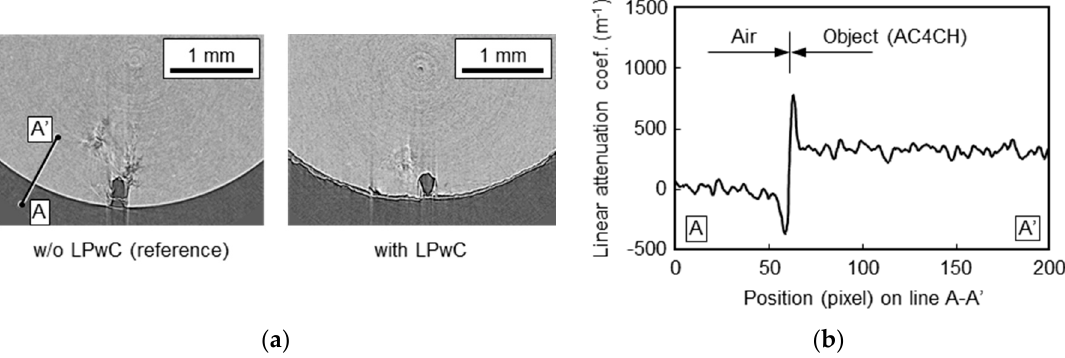
Figure 5. The effect of phase-contrast: ( a ) Reconstructed slice images at the level of the drilled hole; ( b ) A plot of the linear attenuation coefficients along the line A-A’ of Figure 5 ( a ). The border between the object (AC4CH) and air is enhanced.